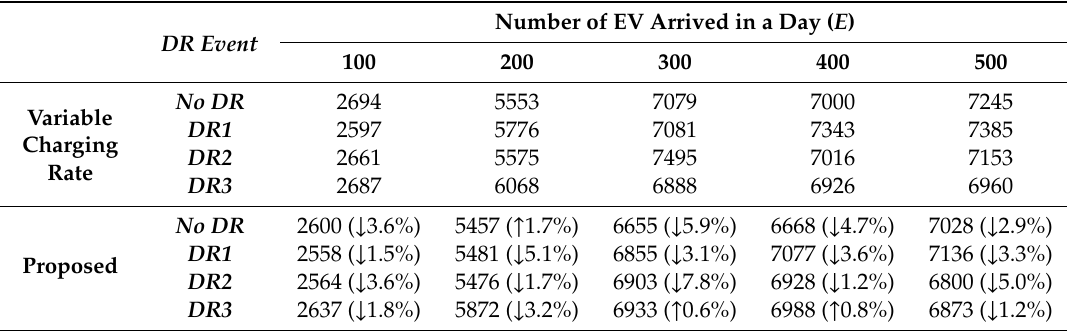
Table 3. Comparison of Power Consumption Cost ($/day) and saving (in percentage).